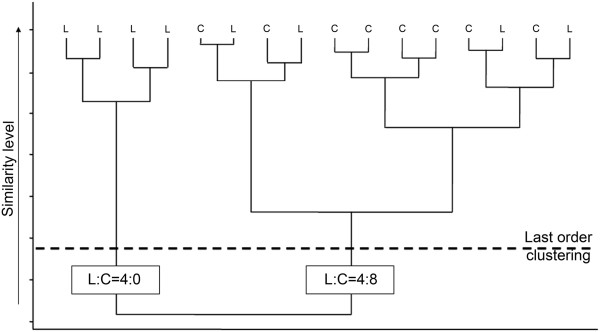
Sample cluster formations represented by dendrogram and similarity level (dashed line) at last order clusters. In calculation of homogeneity indexes measuring segmental homogeneities of MNs in the biggest two clusters (last order clustering and Peterson’s indexes), the ratios of MNs from the lumbar (L) and cervical (C) segments were considered in each cluster. See Methods for more details.